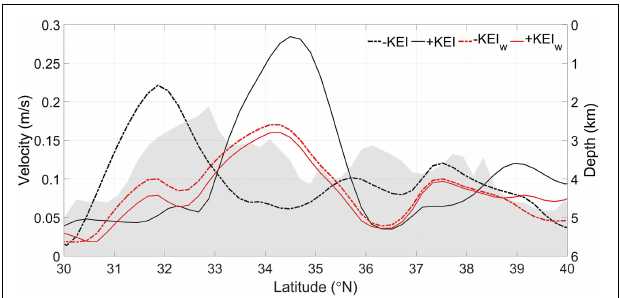
FIGURE 5 | Geostrophic velocity of the KEI phases (black, left axis; m/s) zonally averaged across the blue patch in Figure 1C . Red curves are the same but for KEI w phases. Gray shading shows zonally averaged bathymetry (right axis; km) across the magenta patch in Figure 1C